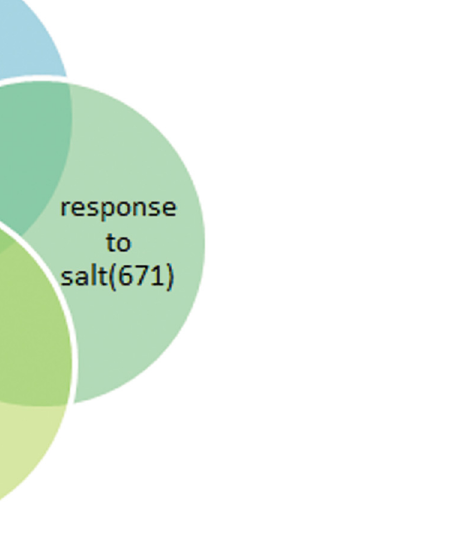
Fig 8. Venn diagram of stress-response